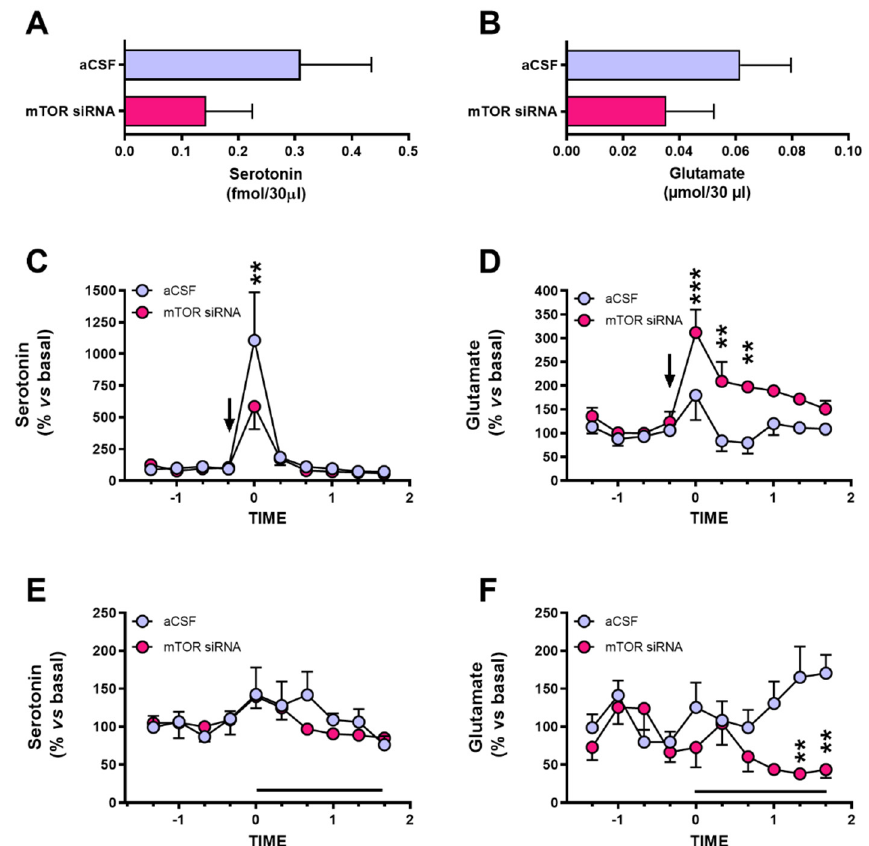
Figure 4. Dysregulation of extracellular serotonin and glutamate neurotransmitters in the dorsal raphe nucleus after acute infralimbic-mTOR knockdown in mice. Baseline extracellular values of ( A ) serotonin and ( B ) glutamate in DRN. The effects of local 50 µM veratridine on extracellular ( C ) serotonin and ( D ) glutamate levels, and intra-DRN 100 µM NBQX infusion on extracellular ( F ) 5-HT and ( E ) glutamate levels in control and mTOR-siRNAs mice. Data are represented as mean ± SEM. Two-way ANOVA followed by Bonferroni post hoc test (** p < 0.01, *** p < 0.001). n = 4 – 5 animals per experimental group. 5-HT: serotonin; aCSF: artificial cerebrospinal fluid; NBQX: 2,3-dihydroxy-6-nitro-7-sulfamoyl-benzo(f)quinoxaline; siRNA: small interfering RNA.